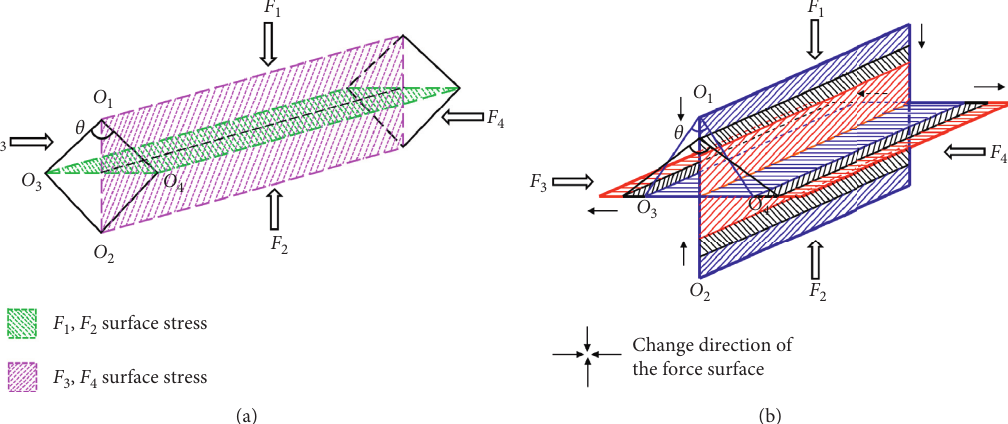
Figure 16: The force analysis of the unit body. (a) The projection plane of the unit body. (b) The change of the projection plane area under axial compression.